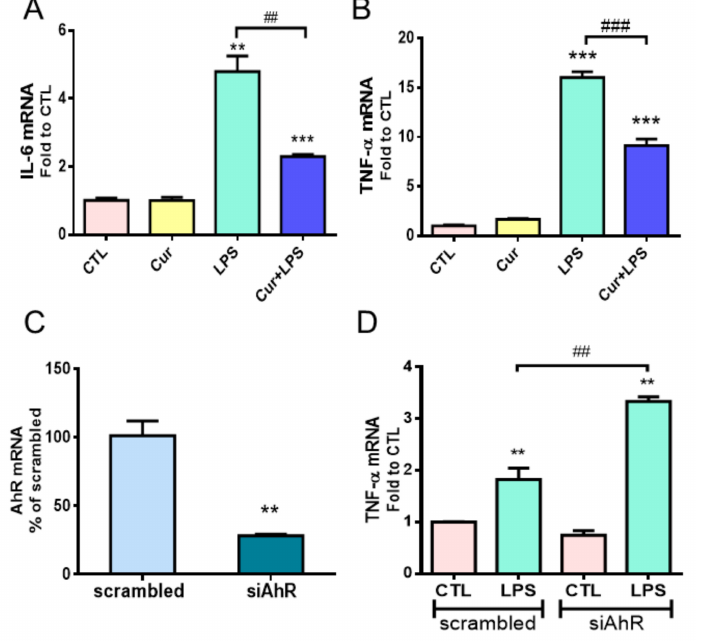
Figure 1. Effects of curcumin and AhR in astrocytes under inflammation. ( A , B ) Primary cultured rat astrocytes were treated with 1 µ g/mL LPS with or without 1 µ M curcumin (Cur) for 12 h. The mRNA expressions of IL-6 ( A ) and TNF- α ( B ) were analyzed by qPCR. Note that curcumin alleviated the LPS-induced inflammatory response in astrocytes. ( C , D ) Primary cultured astrocytes were transfected with AhR siRNA (siAhR) or scrambled RNA (as the control) for 48 h, followed by 1 µ g/mL LPS treatment for 12 h. qPCR analysis of AhR mRNA expression indicated the knockdown efficiency of siAhR ( C ). Quantitative RT-PCR of TNF- α mRNA expression shown in ( D ). n = 3. Note that knockdown of AhR expression aggravated the inflammatory response of astrocytes under LPS stimuli. Statistical differences were analyzed using unpaired t -test and are represented as ** p < 0.01, *** p < 0.001 compared with the individual control group and ## p < 0.01, ### p < 0.001 compared with the indicated group using the unpaired t